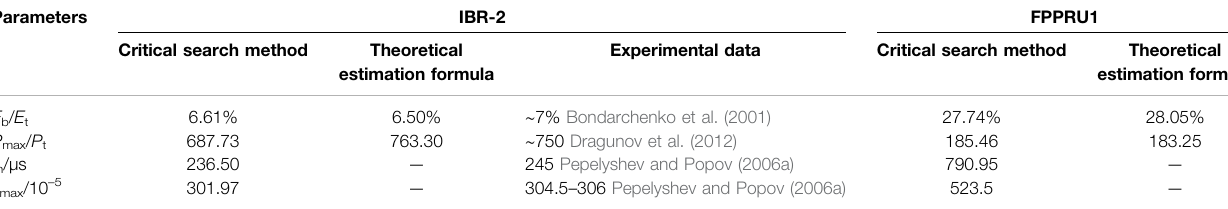
TABLE 4 | Comparison of FPPRU1 pulse parameters with IBR-2 pulse parameters. Parameters